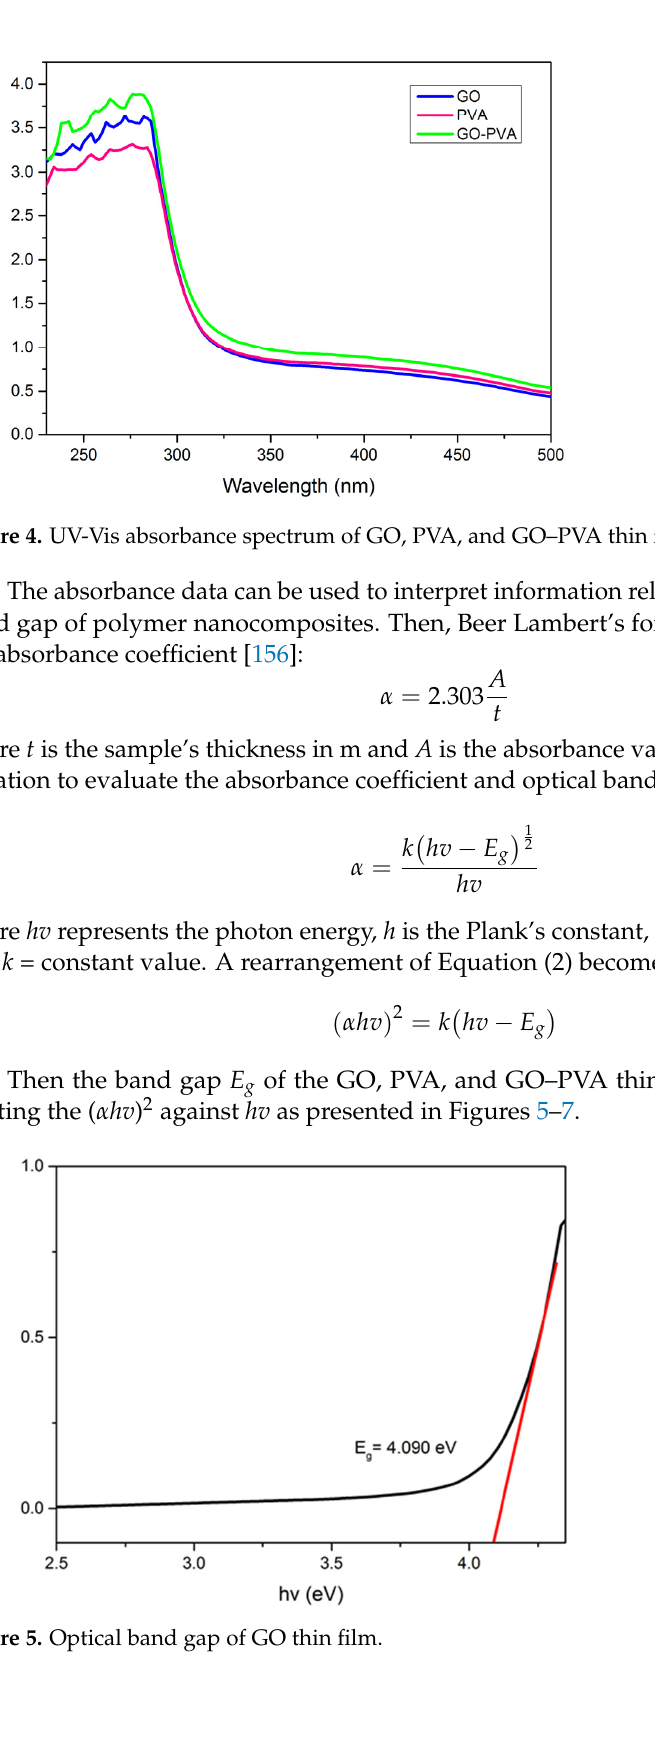
Figure 6. Optical band gap of PVA thin film. Figure 7. Optical band gap of GO–PVA thin film. It is shown that the data produced for the optical band gap was different for each component. The highest band gap of 4.090 eV was obtained for GO thin film and the low- est of 4.039 eV was obtained for PVA thin film. The incorporation of GO and PVA gave the band gap value of 4.083 eV.